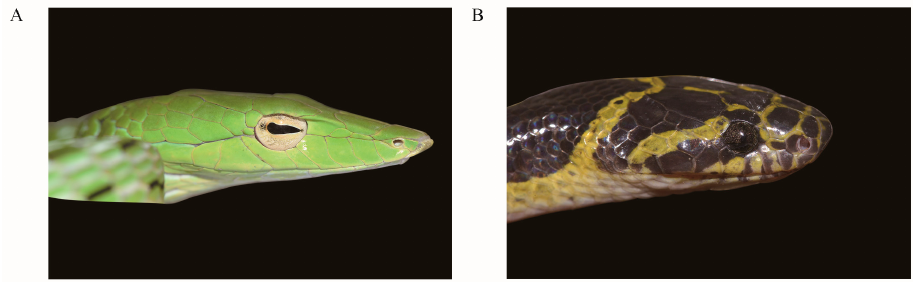
Figure 1. Schematic diagram of the eyes of ( A ) Ahaetulla prasina (diurnal) and ( B ) Lycodon flavozona- tum (nocturnal). Photos by Chen-Yang Tang and Jin-Long